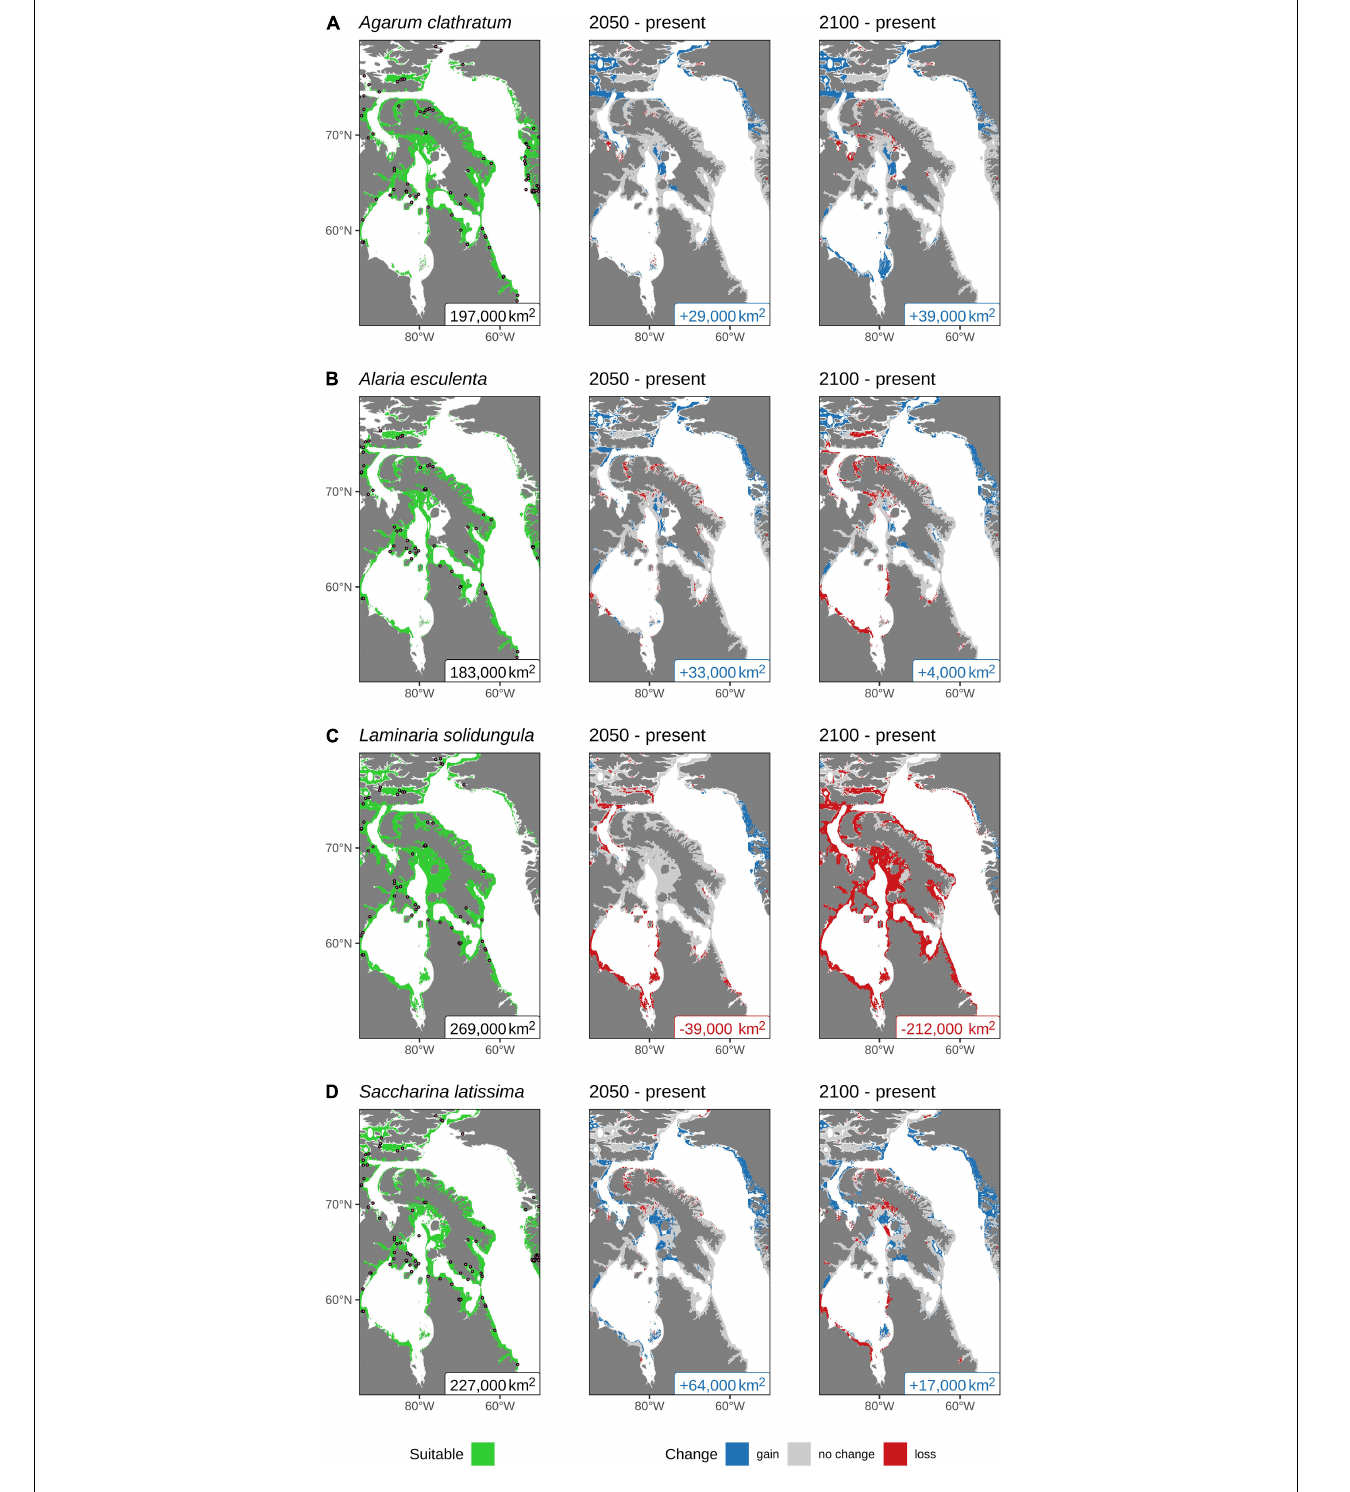
FIGURE 4 | Predicted suitable habitat calculated using the results from the ensemble model projections of kelp presence in the Eastern Canadian Arctic: (A) Agarum clathratum ; (B) Alaria esculenta ; and Laminariaceae spp.: (C) Laminaria solidungula ; and (D) Saccharina latissima under present (left panel), 2050 (middle panel), and 2100 (right panel). The presence data used in the models are shown with dots (left panel), and the colored text labels at the bottom of each panel show the total surface area (rounded to the nearest 1,000 km 2 ) projected to be suitable habitat for the given species. All values are based on an assumed depth limit of 30 m. For clarity, all pixels within 15 km of land or 50-m deep are